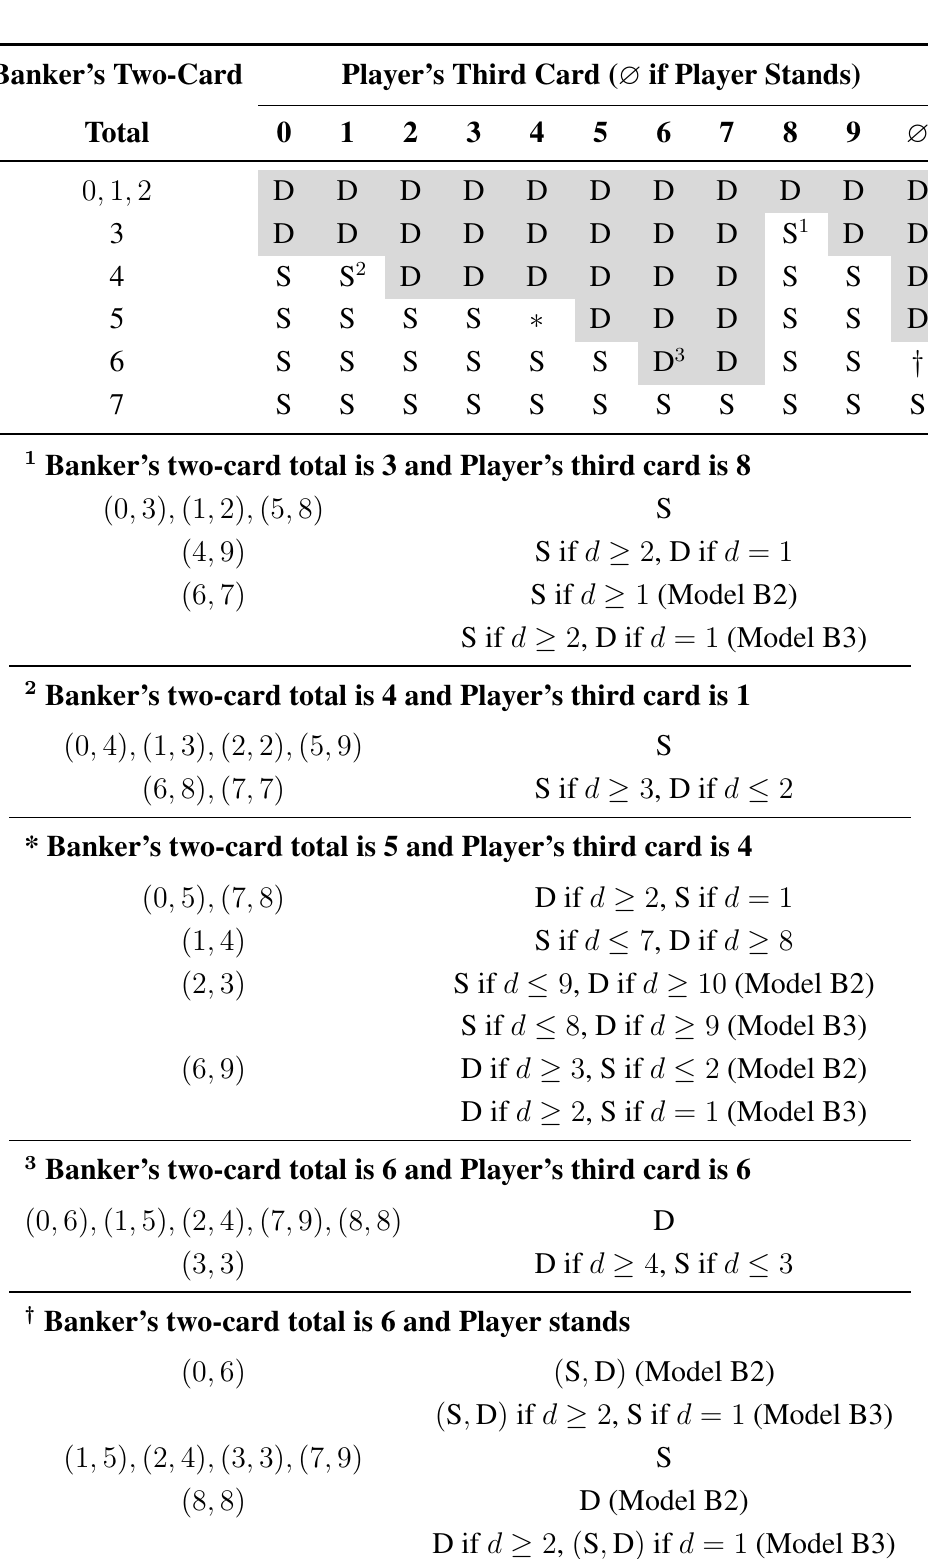
Table 5. Banker’s optimal move (final version) under Model B2 or B3 with d being a positive integer, indicated by D (draw), S (stand), or ( S , D ) (stand with probability 1 probability q ). In Model B2, q is as in Equations (39)–(42), and in Model B3, q is as in Equations